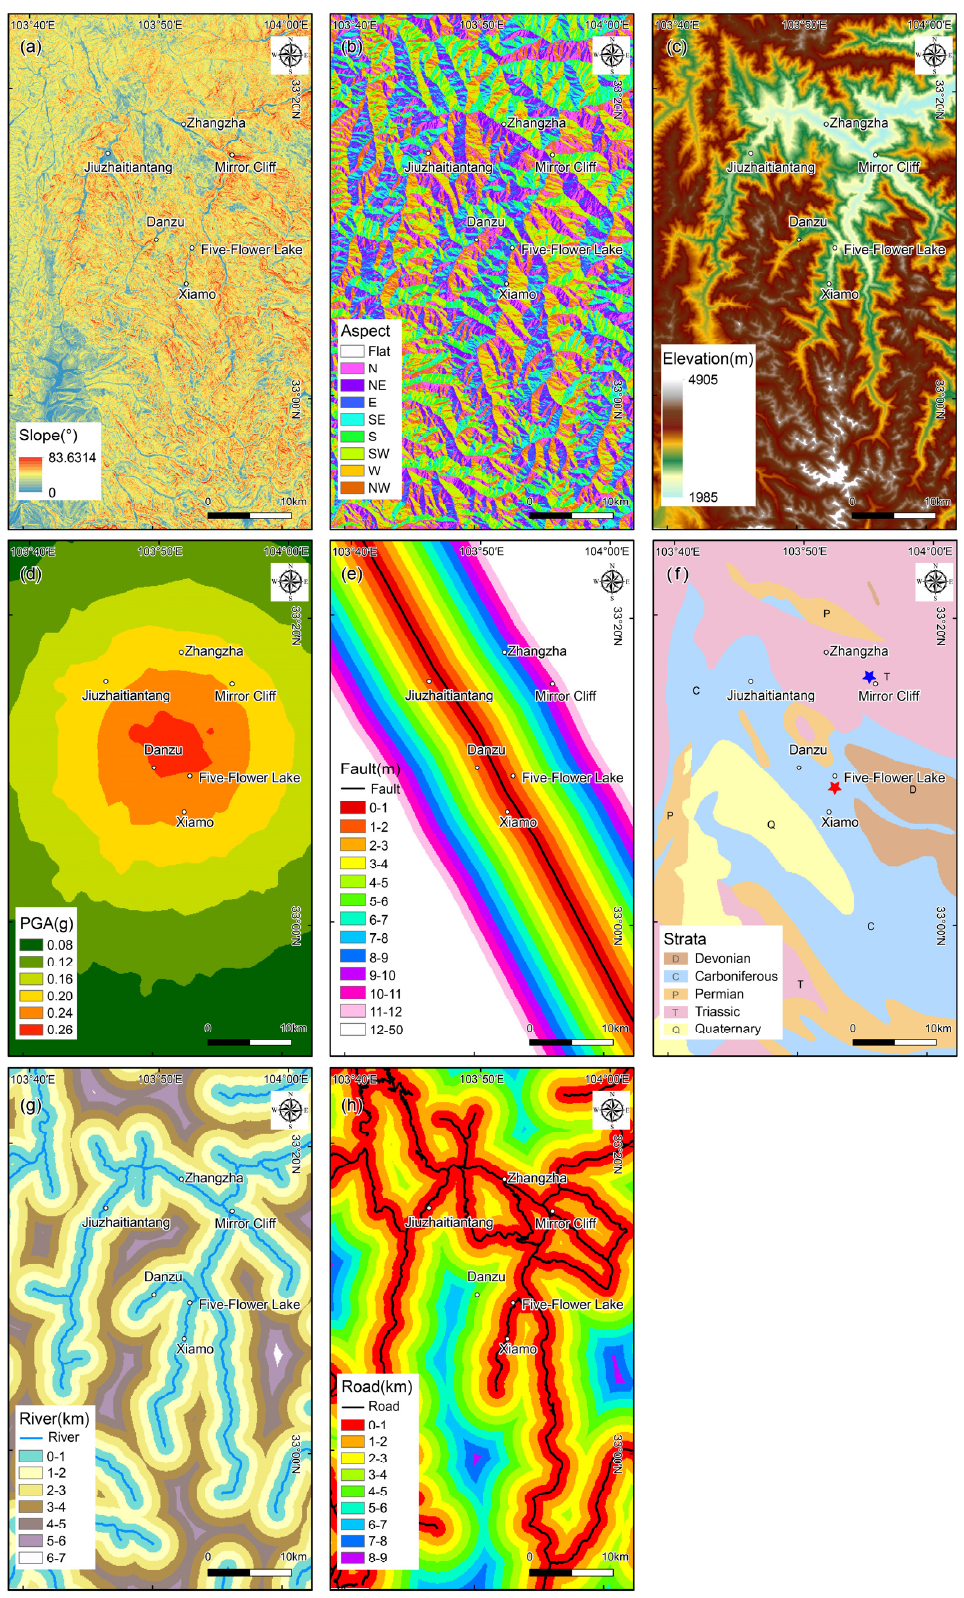
Figure 6. Influencing factors in Jiuzhaigou. ( a ) Slope; ( b ) Aspect; ( c ) Elevation; ( d ) PGA; ( e ) Fault (The black line is the seismogenic fault—Xiongmaohai-Shangsizhai fault [34,35]); ( f ) Strata (Blue star near Mirror Cliff: outcrop in Figure 3d; Red star near Five-Flower Lake: outcrop in Figure 3e); ( g ) River; ( h ) Road.